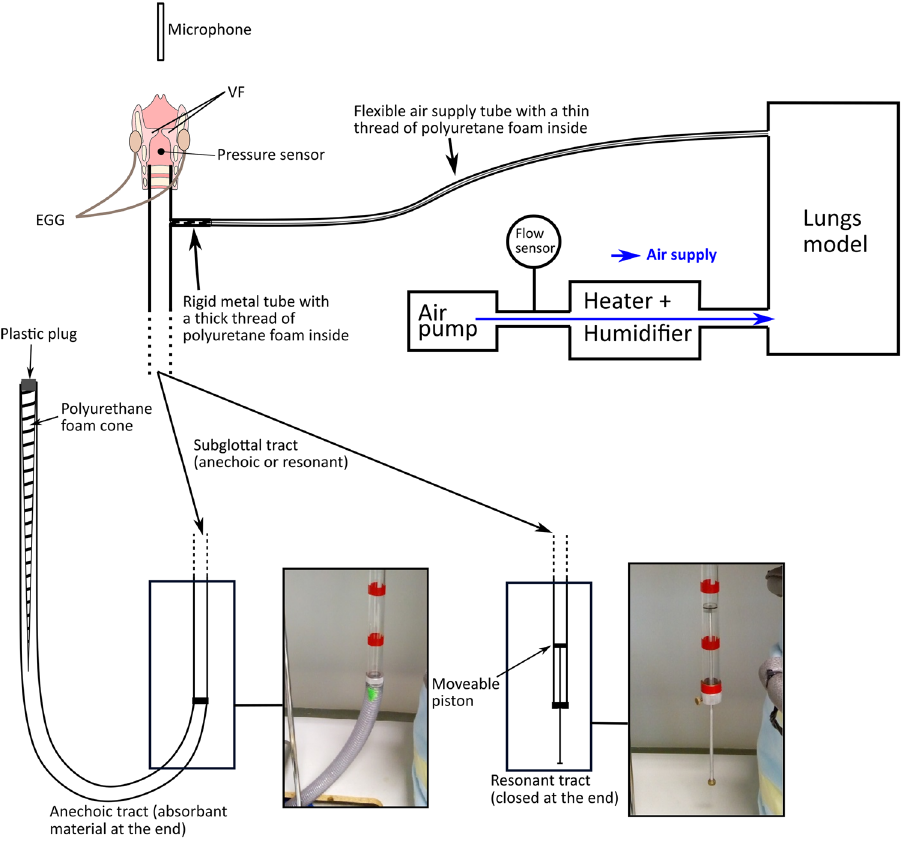
Figure 9. Excised larynx experimental